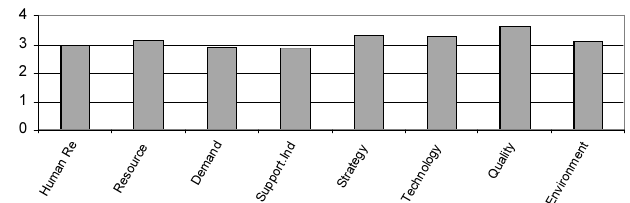
Figure 1: Strengths and opportunities